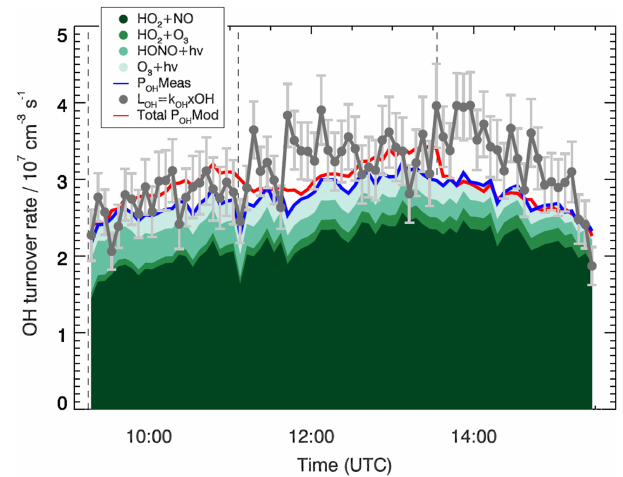
Figure 4. HO 2 budget for the MBO experiment. The loss rate of HO 2 calculated from measured NO, ozone, and HO 2 concentra- tions, L HO Meas, and individual modelled production terms are 2 shown. For comparison, the red line indicates the total modelled HO 2 production, P HO Mod, which equals the total modelled loss 2 rate. Vertical dashed lines indicate the times when MBO was in- jected. Error bars (1 σ ) for L HO Meas include the accuracy of HO 2 2